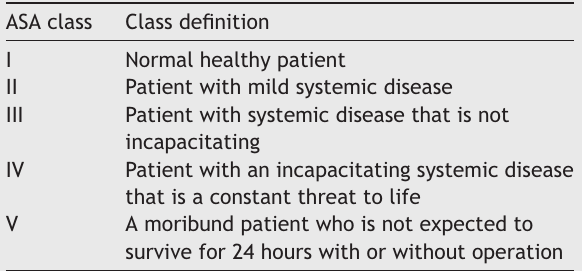
American Society of Anesthesiologists risk classi- fication